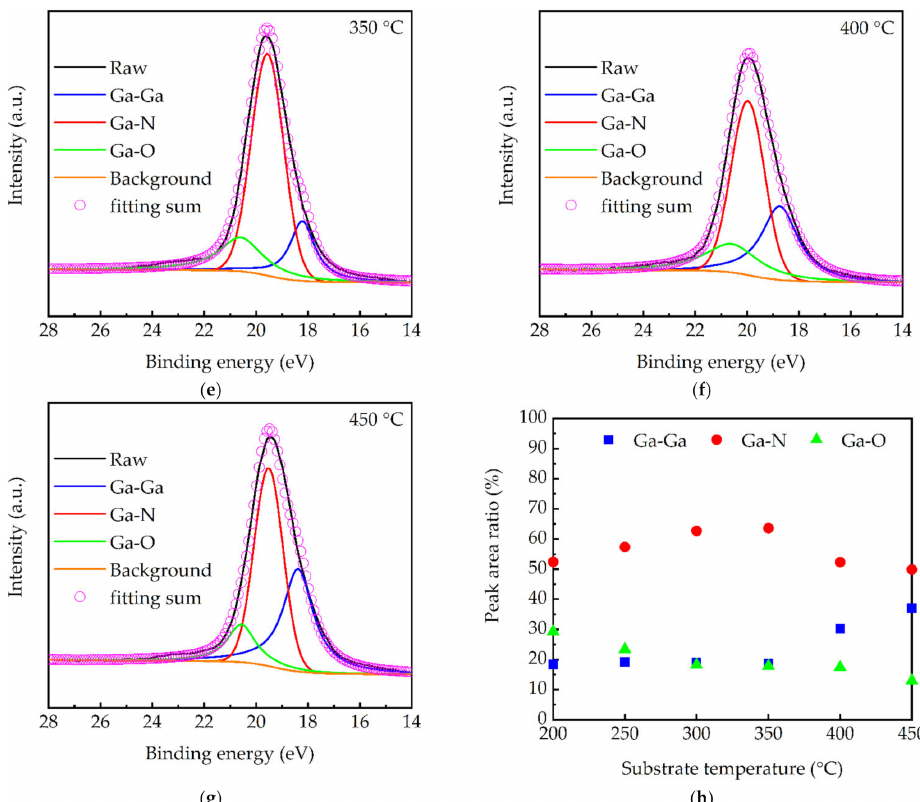
Figure 6. ( a ) XPS survey spectra of the GaN films deposited at different substrate temperatures. The spectra have been vertically shifted for clarity. Ga 3d core level XPS spectra for ( b ) 200, ( c ) 250, ( d ) 300, ( e ) 350, ( f ) 400, and ( g ) 450 ◦ C. ( h ) Ga-Ga, Ga-N, and Ga-O peak area ratios, as a function of